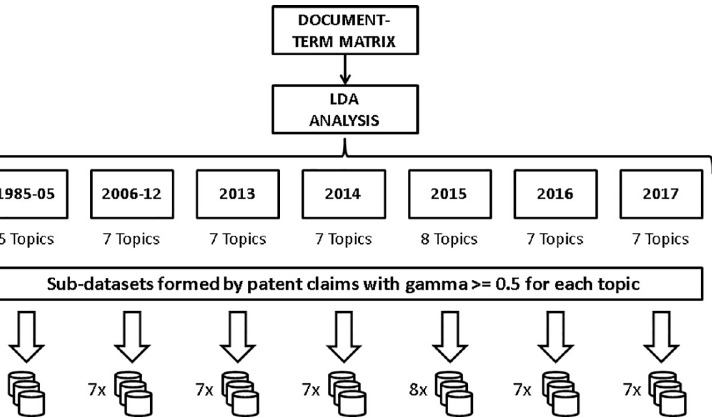
Fig 8. Topic modeling and sub-dataset building process. Diagram showing the process followed from the document- term matrices obtained by text mining to the building of sub-datasets containing the core information to characterize the technology fronts. The number of topics obtained for each time interval is